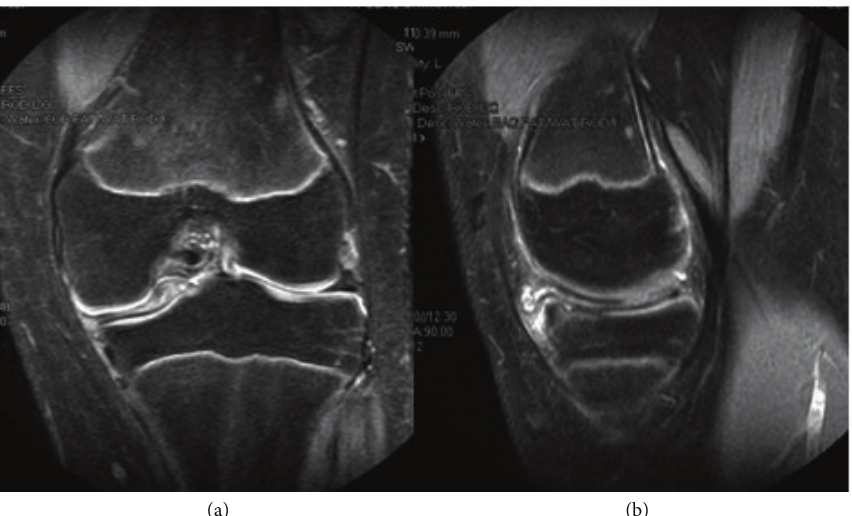
Figure 5: MRI of the left knee. (a) Coronal view showing the upper side of the medial meniscus folded in the intercondylar notch. (b) Sagittal view demonstrating horizontal and vertical peripheral tear.